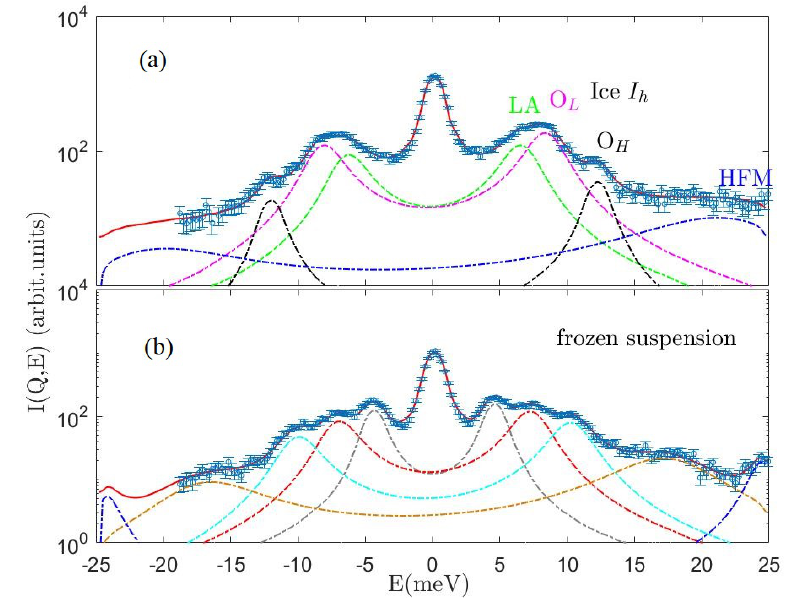
Figure 5. The IXS spectra of ice and the frozen aqueous suspension of the AuNPs at Q = 21 nm − 1 in panels ( a , b ), respectively. Raw data are compared with best-fitting model lineshapes and individual spectral components, with the same color code as in Figure 4 for the AuNPs suspension yet in semilogarithmic plots. For the ice Ih spectrum, the two optical modes O L and O H are in magenta and black, respectively, and the mode LA is in